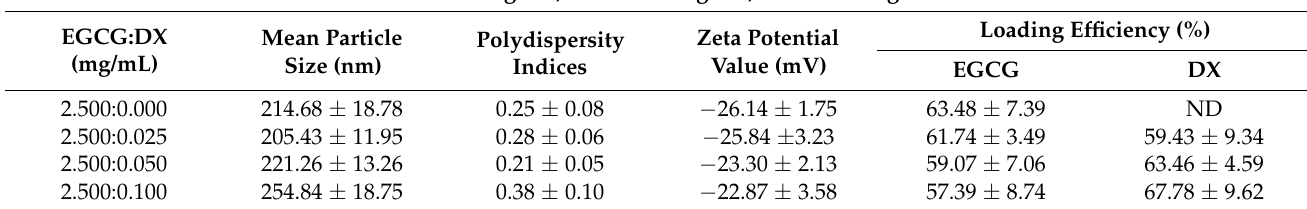
Table 2. Effect of varying DX concentration on EGCG/DX-loaded FD/THA/PG particle sizes, polydispersity indices, zeta potential values, and drug loading efficiency ( n =